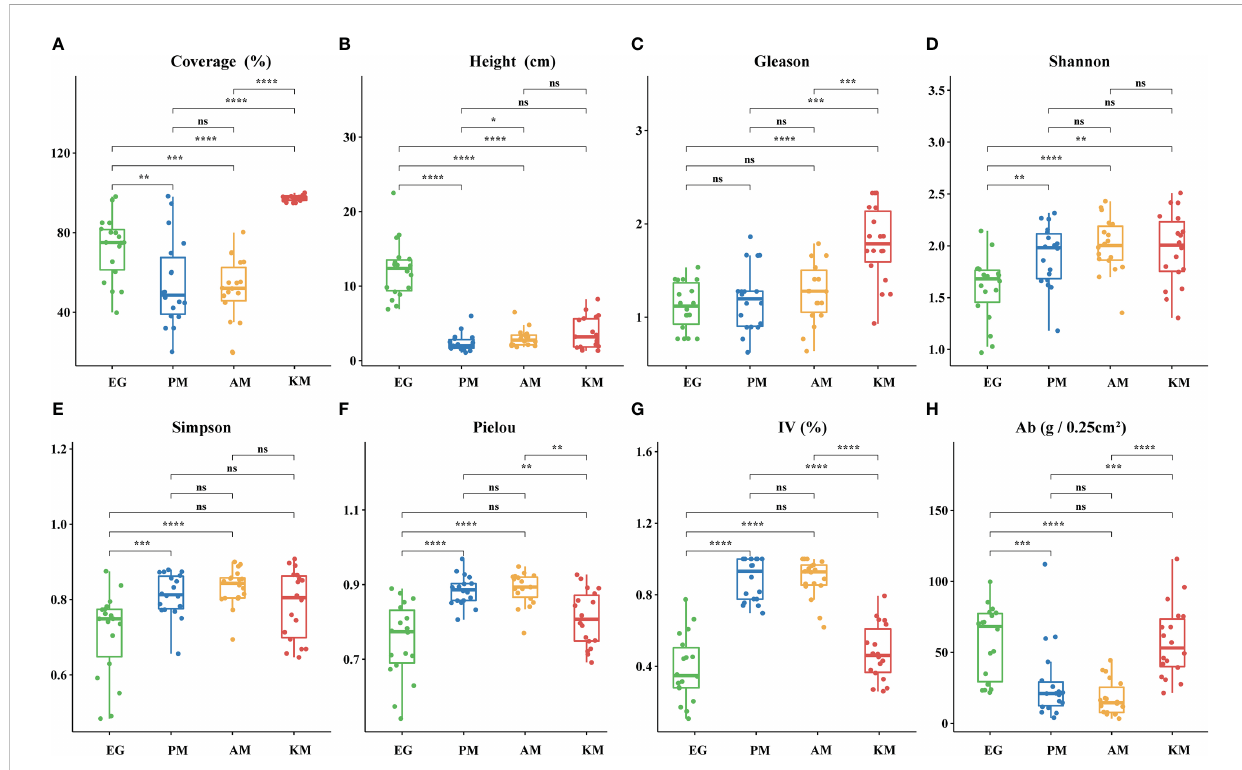
FIGURE 2 Boxplot of vegetation parameters. (A) Coverage of plant community; (B) Height of plant community; (C) Gleason index; (D) Shannon-Wiener index; (E) Simpson index; (F) Pielou index; (G) Important value of forbs; (H) Aboveground biomass. Signi fi cant P values were shown in boxplot. * means adjusted P values ≤ 0.05, ** means adjusted P values ≤ 0.01, *** means adjusted P values ≤ 0.001 and **** means P ≤ 0.0001, if not indicated, means adjusted P values > 0.05. EG, E.nutans -dominated grassland; PM, P.anserina -dominated meadow; AM, A.frigida -dominated meadow; KM, K.pygmea -dominated